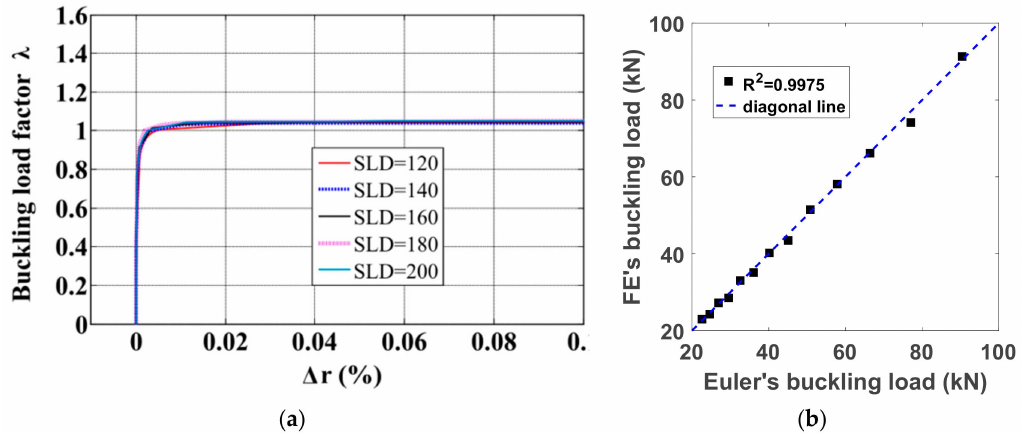
Figure 3. Buckling response of columns under axial compression: ( a ) load factor versus lateral deflection and ( b ) comparison between critical buckling loads obtained from finite element tool and Euler’s formula, for columns with SLD ranging from 120 to 200,